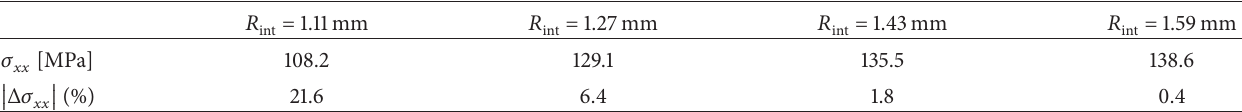
Table 2: Values of the measured average stress obtained by keeping constant 𝑅 value was 𝜎 𝑥𝑥 = 138 MPa. Also standard deviations are reported as a result of three different drilled holes. 𝑅 int = 1.11mm